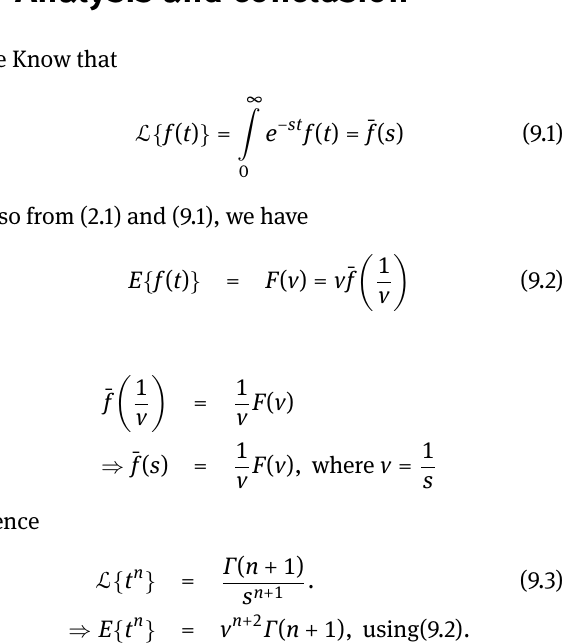
Fig. 12: Surface graph of w ( x , t ) of eq. (8.7), when α = 0.8